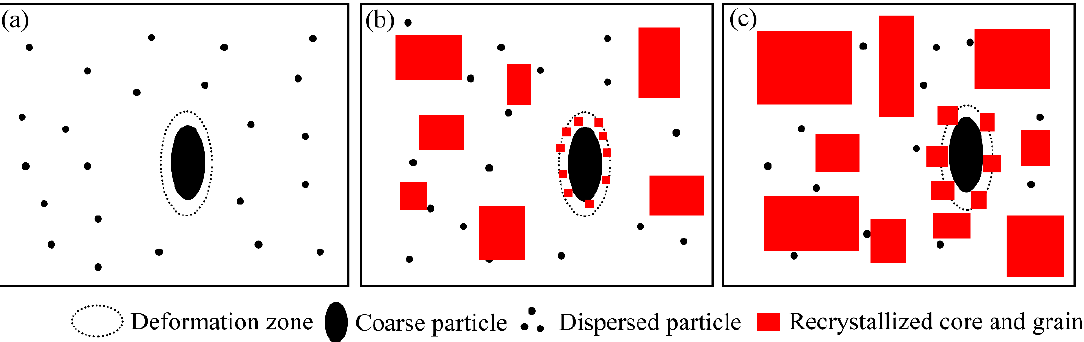
Figure 13. Schematic illustration of recrystallization during solution treatment: ( a ) before solution treatment, ( b ) initial stage of grain growth, and ( c ) post stage of grain growth.